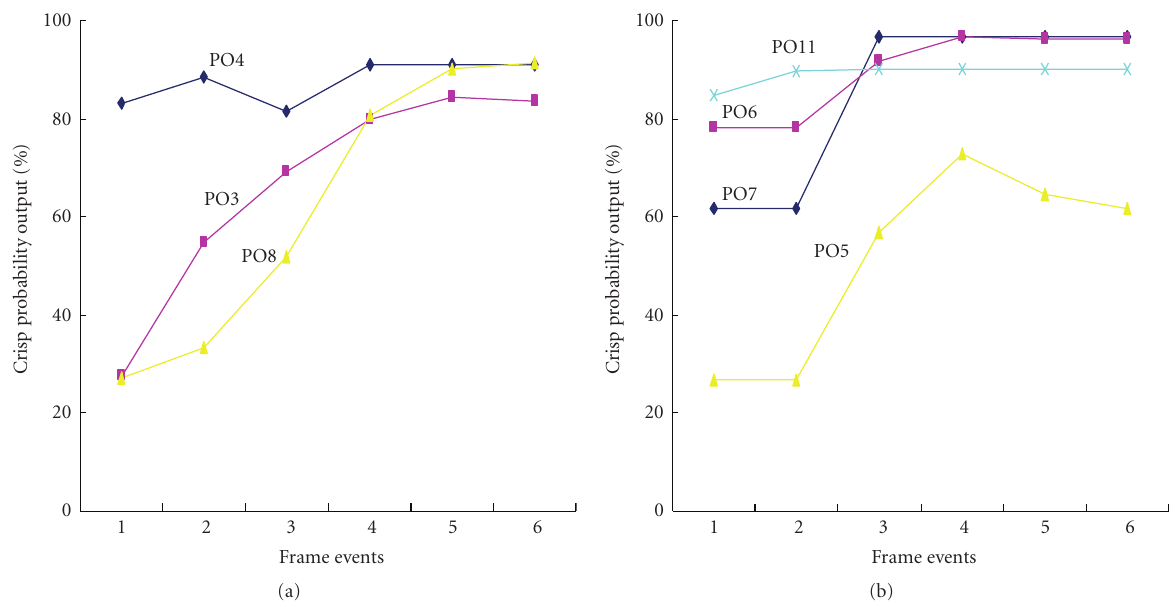
Figure 14: The graphical representation to summarize the robots behavior shown in Figure 13 with a threshold probability value of 84%.